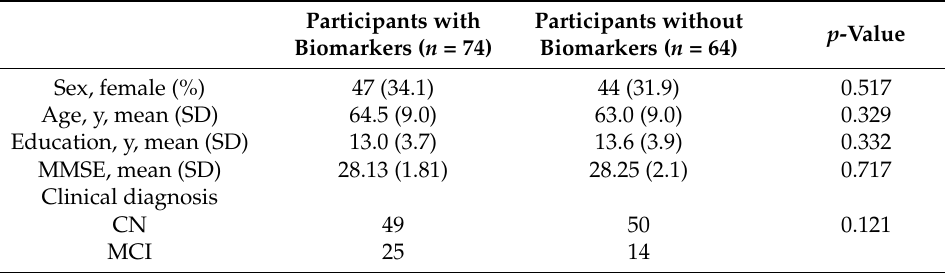
Table 2. Participant characteristics for those with and without CSF biomarker profiles.